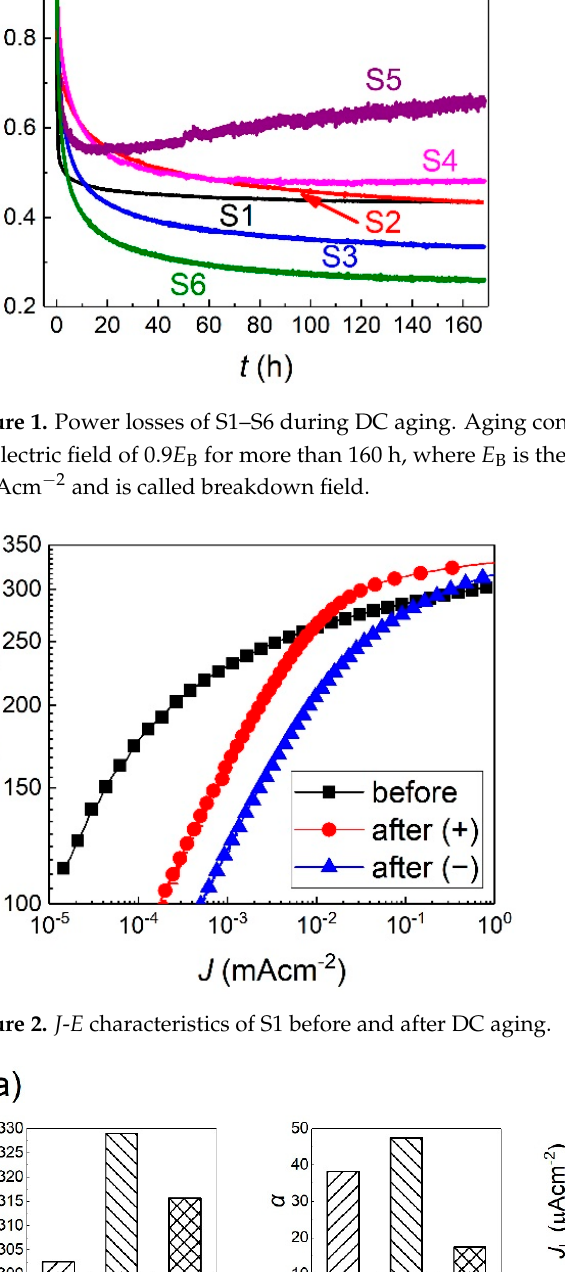
Figure 1. Power losses of S1–S6 during DC aging. Aging condition: Heated at 135 °C and applied an electric field of 0.9 E B for more than 160 h, where E B is the electric field when current density is 1 mAcm − 2 and is called breakdown field.